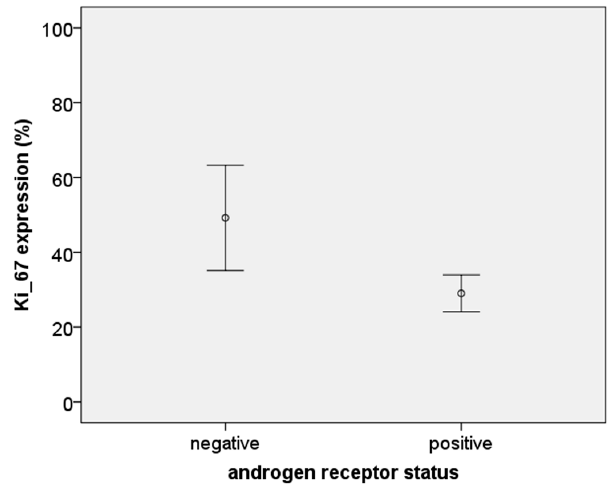
Figure 5. Error bar graph showing the mean ± S.E. of Ki ‐ 67 expression by androgen receptor status (49.21 ± 6.70 in AR negative group and 29.03 ± 2.48 in AR positive group; p = 0.014). (49.21 ± 6.70 in AR negative group and 29.03 ± 2.48 in AR positive group; p =